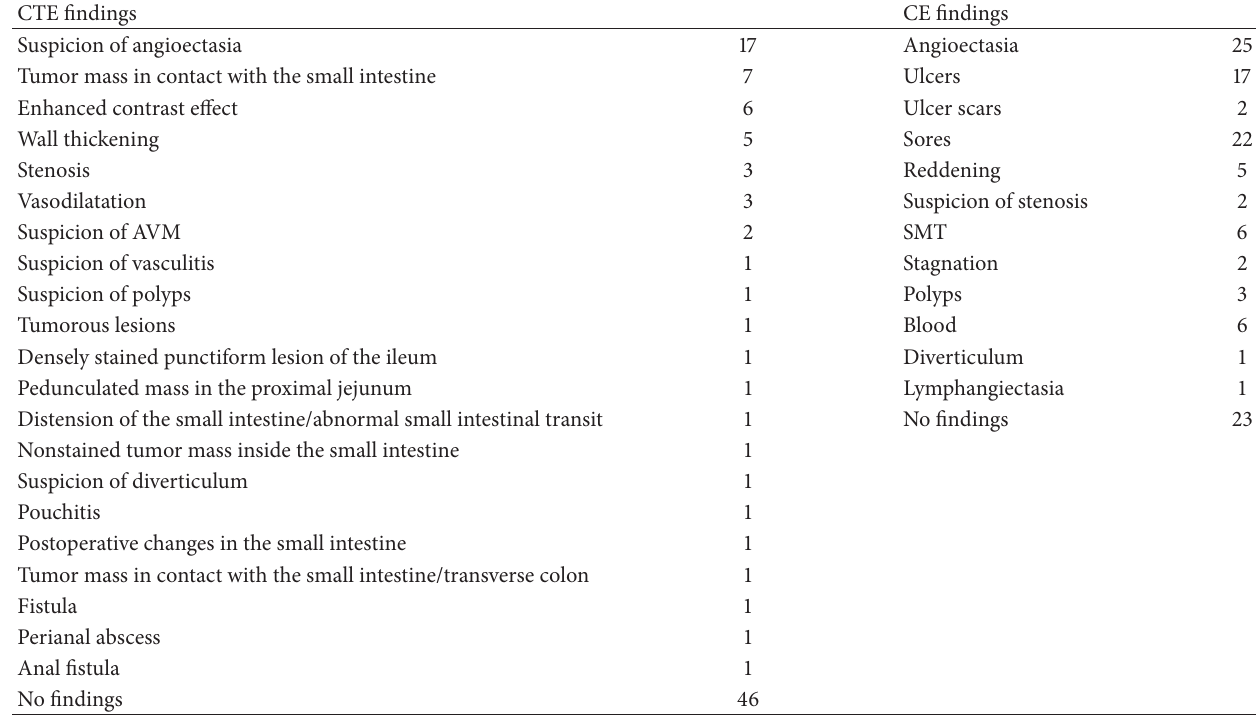
Table 2: Computed tomography enteroclysis/enterography (CTE) and capsule endoscopy (CE) findings. CTE findings